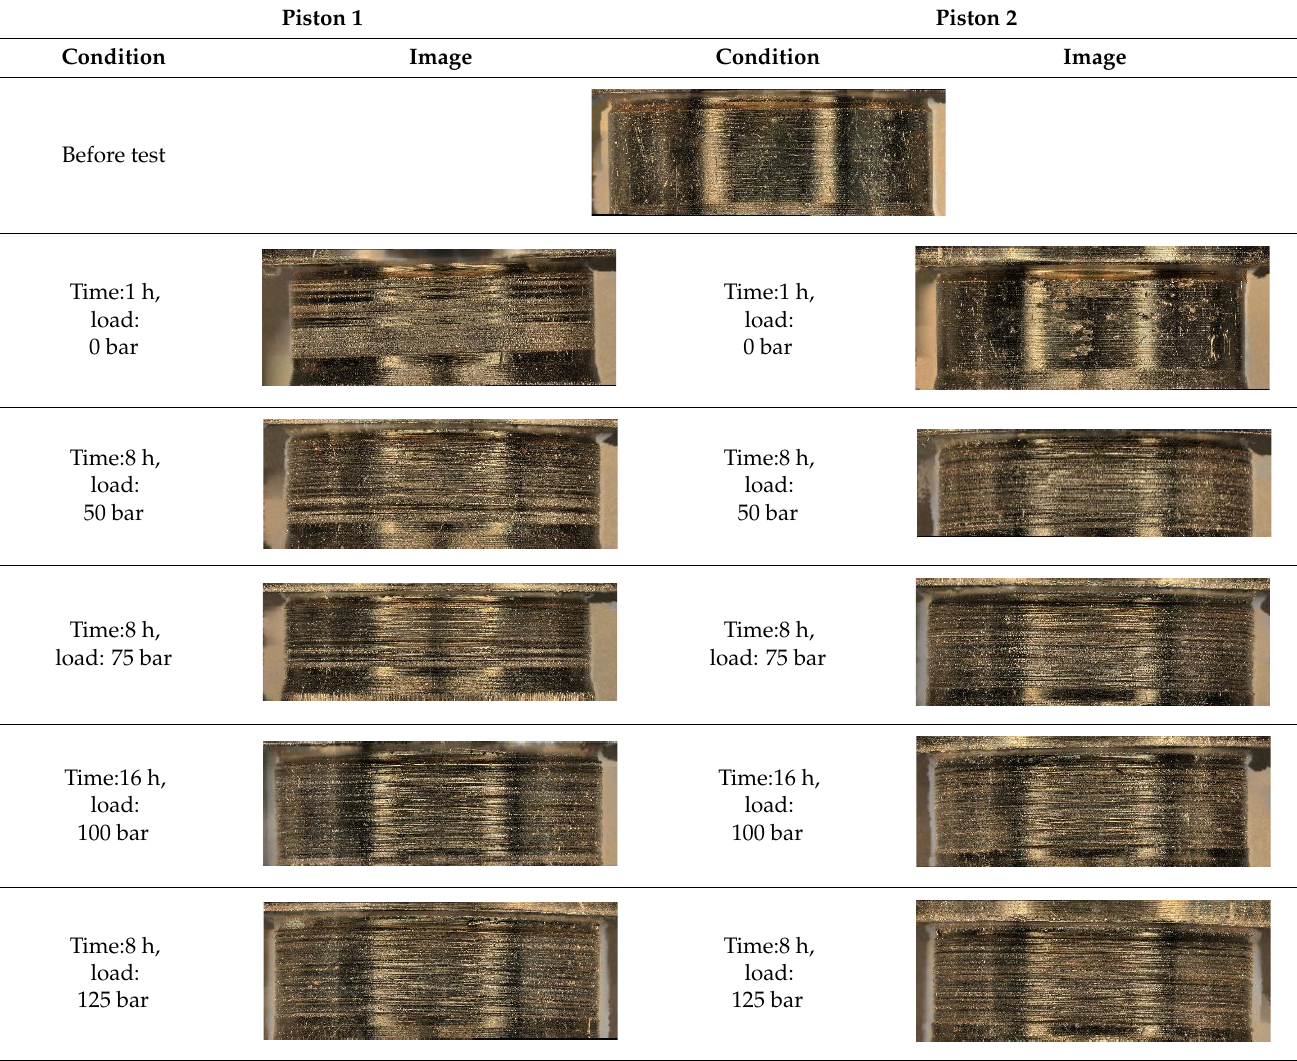
Figure 8. Roughness measurement results of all tested parts. The visible high surface roughness of the spherical surface in the slipper-retainer is based on the obtained results, and is typical for parts manufactured during the SLM process and additionally subjected to sandblasting [35]. The significant surface roughness reduction (66%) is visible after exceeding the pump pressure value equal to 125 bar and kept by 32 h of exploitation. Further load increasing caused a slight drop of the R a parameter of this part. In the case of the original parts (conical surface of the retainer guide and two pistons) there is visible an increase in the surface roughness, which is equal to 500% in the case of the retainer guide, and 555% in the case of the pump pistons. Such large growth was caused by the cooperation of the original parts with the AM slipper-retainer. After exceeding the mentioned total values, the surface roughness of three tested original pump parts started to decrease and reached the following values in comparison to the initial stage: retainer guide—172%, and pump pistons 267%. Such a phenomenon is strictly related to different materials used for the production of the retainer guide (hardened steel) and pump pistons (tin bronze C90700). The significant wear took place in the case of pump pistons, which had been subjected to deeper microscope investigation based on geometrical analysis. The images from each stage are shown in Table 7. Table 7. The surface condition of two tested cylindrical surfaces of the pump pistons. Piston 1